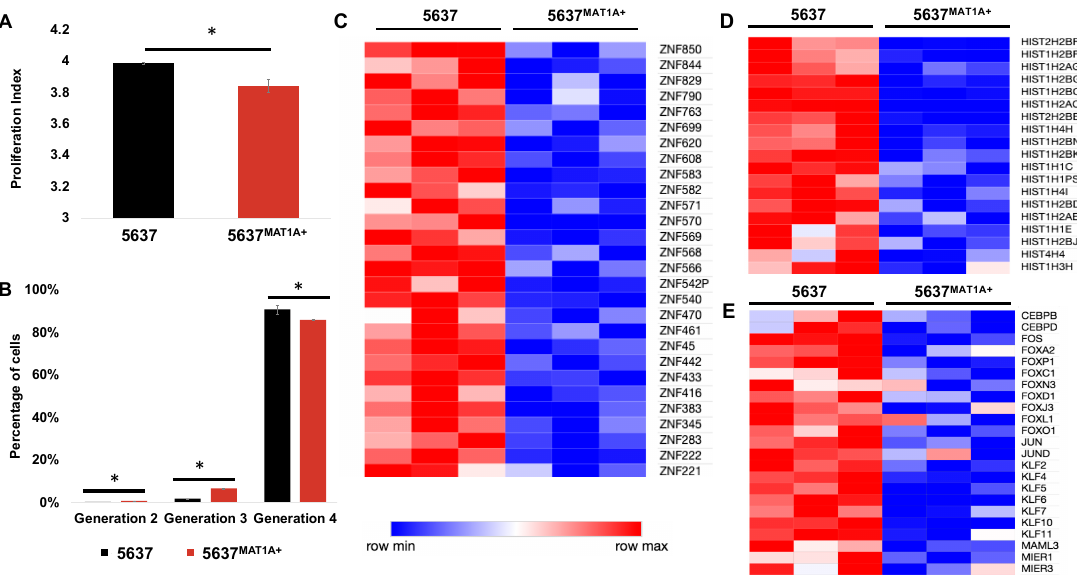
Figure 5. MAT1A overexpression decreases cell proliferation and transcriptional activity. ( A ) Proliferation indices over 72 h (* p < 0.05) in 5637 and 5637 MAT1A + cells and ( B ) percentage of 5637 versus 5637 MAT1A + cells in various generations following initial cell seeding at generation zero (* p < 0.05). Cells were stained with carboxyfluorescein diacetate succinimidyl ester (CFSE) and analyzed using flow cytometry to evaluate changes in proliferation. Data was analyzed and proliferation was modeled in FlowJo®. RNA-seq analysis identified whole genome transcriptomic alterations in 5637 MAT1A + and 5637 cells. Heat maps representing differentially expressed genes ( n = 3 biological replicates) reveal downregulation in three gene groups: ( C ) zinc finger, ( D ) histone, and ( E ) transcription factors.